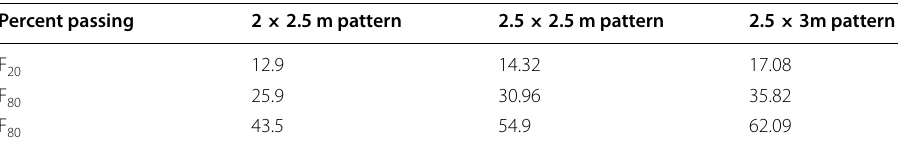
Table 5 Results of the Kuz-Ram experiential model